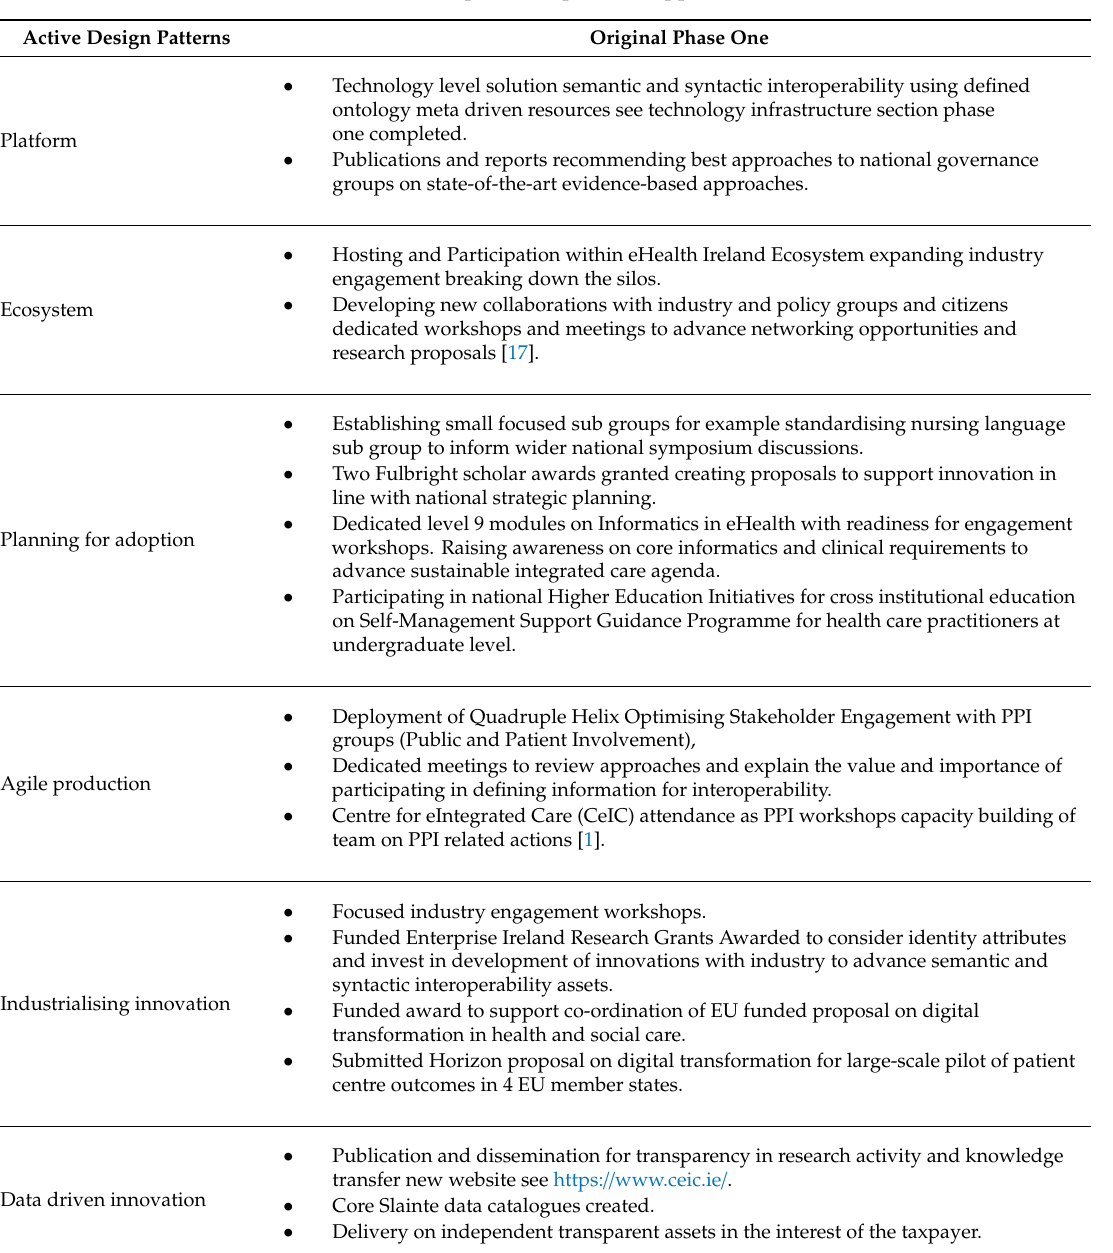
Table 1. Innovation 2.0 expected impact and application of